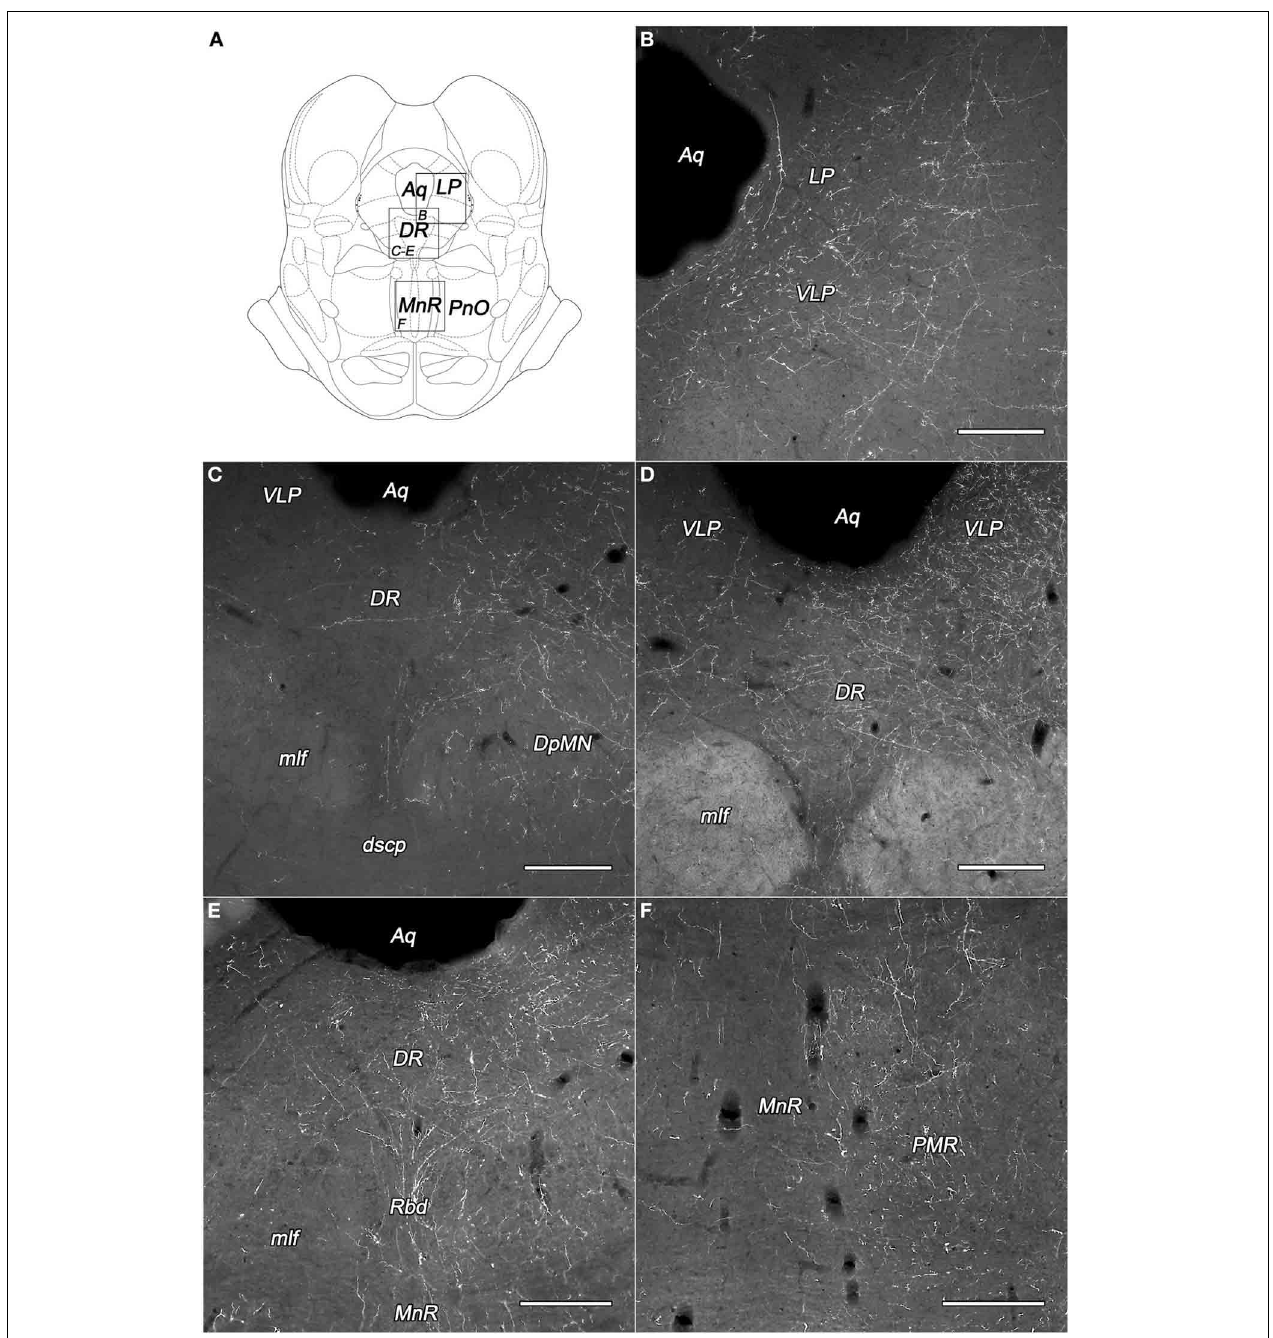
FIGURE 4 | Labeled fibers in the periaqueductal central gray (PAG) and the midbrain raphe nuclei following BDA injections into different subregions of the DLH. (A) Drawings for outlining of the corresponding midbrain areas on panels B–F, according to the atlas of Paxinos and Watson (2007), with modifications. (B) Fine BDA-containing fiber network in the lateral and ventrolateral PAG originating from the rostral perifornical area. (C–E) Varicose BDA-containing fibers in dorsal raphe nucleus originating from the rostral (C,D) and caudolateral (E) perifornical area. (F) Moderately dense network of varicose fibers in the paramedian raphe